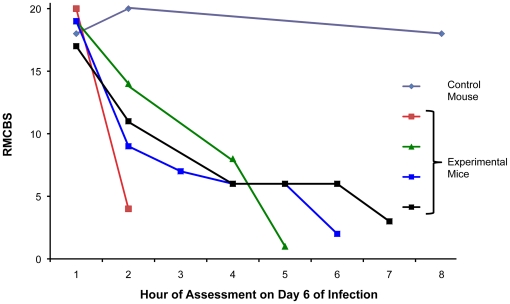
Increased frequency in surveillance via RMCBS.Mice were rapidly assessed at frequent intervals on day 6 of infection via the RMCBS, allowing the operator to closely follow the trajectory of disease progression.